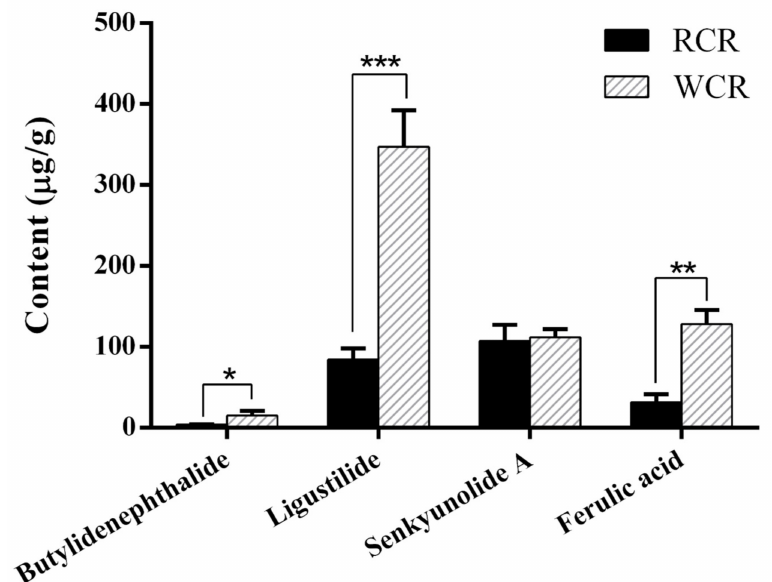
Figure 3. The contents of butylidenephthalide, ligustilide, senkyunolide A and ferulic acid in oral liquid medicine of raw Chuanxiong Rhizoma (RCR) and wine-processed Chuanxiong Rhizoma (WCR) in vitro. (* P < 0.05, ** P < 0.01, *** P <